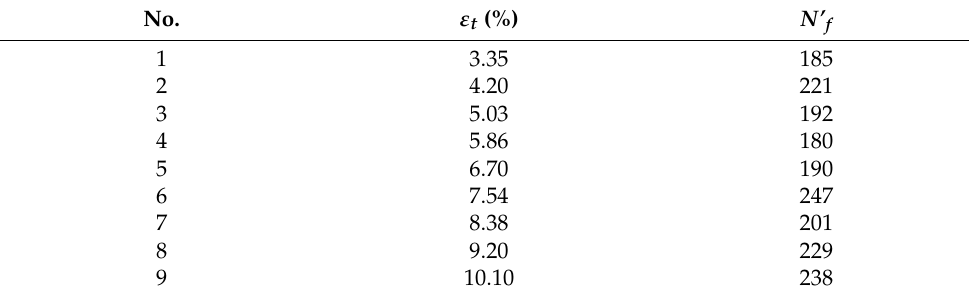
Table 4. Test results of the tension–fatigue tests.